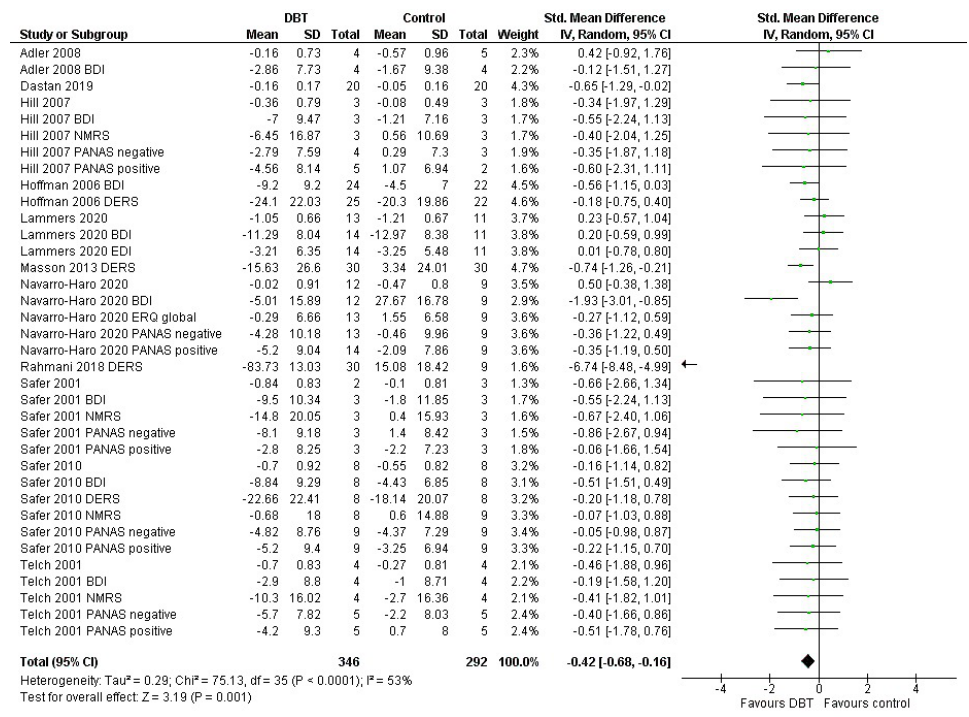
Figure 3. Forest plot: adjusted analysis of Emotion Regulation (ER) including all relevant outcomes per study.